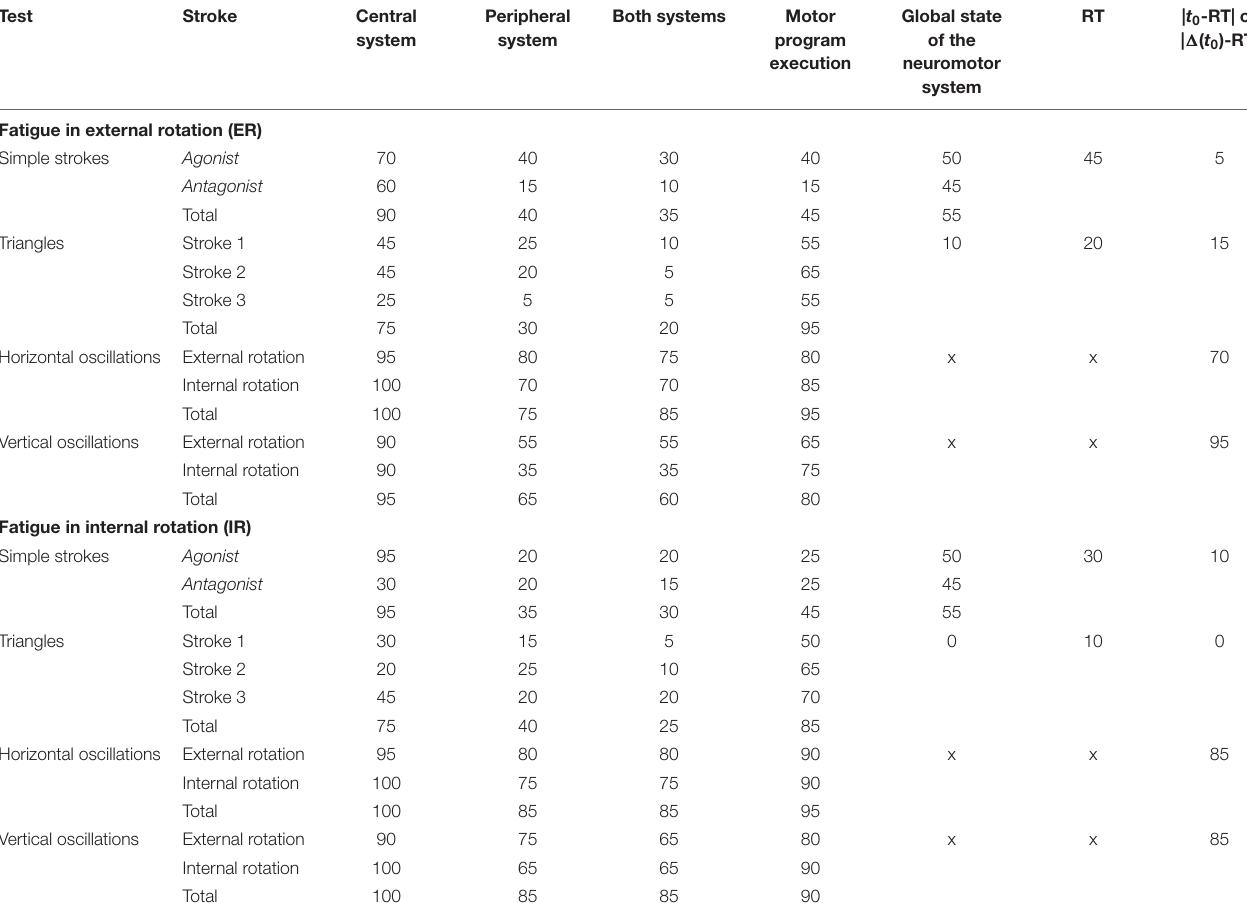
( Table 3 ). For the horizontal oscillations ( Table 4 ), (cid:49) ( t 0 ) was significantly higher after an ER fatigue with a large effect